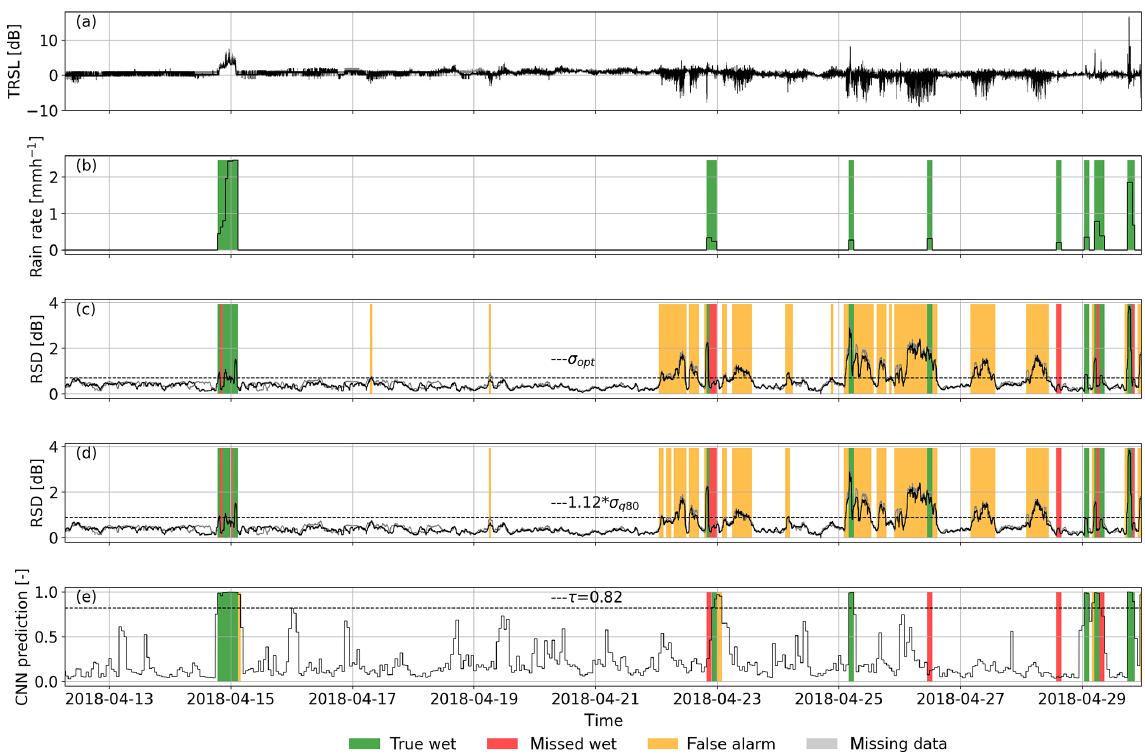
Figure 2. Performance of the CNN and the reference methods for the noisy example CML time series from Fig. 1. Panel (a) shows the normalized TRSL time series and (b) is the radar reference. Predictions from the CNN (e) yield a Matthews correlation coefficient (MCC) of 0.74. Predictions through σ opt (c) and σ q80 (d) , which are very similar in this case, both yield MCCs of 0.28. Note that the TRSL and RSD time series of sublink 2 are almost identical to those of sublink 1 and are shown in light